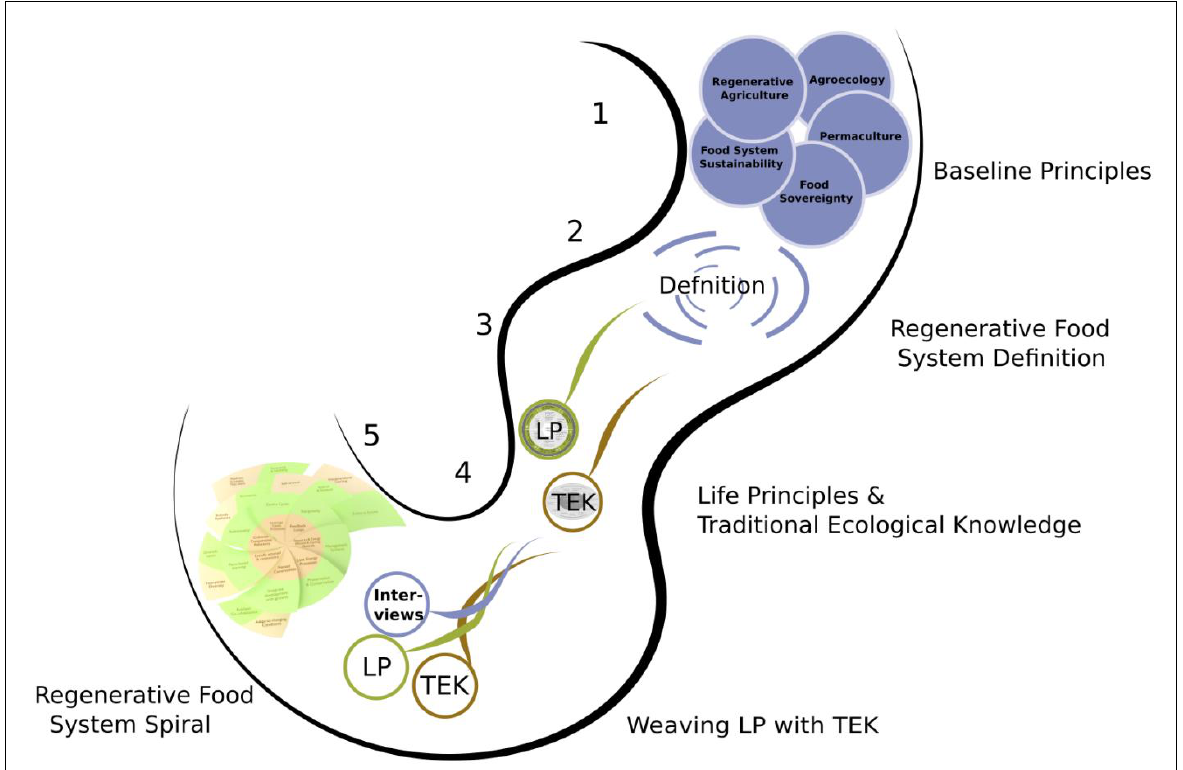
Figure 1. Five-step Flow Process for the Conceptual Framework of a Regenerative Food System The five steps are: (1) Establishing baseline principles by drawing on extant literature (Table 1); (2) Extrapolating an over- arching regenerative food system definition; (3) Focusing on Life ’s Principles circular diagram of 26 principles (Biomimicry 3.8 framework), and a circular diagram representing the Traditional Ecological Knowledge diagram developed in 2000 by Turner et al. (Appendix C, Figure C1); (4) Comparing emergent themes with literature and weaving LPs with TEK; and (5) Developing a spiral framework for a regenerative food